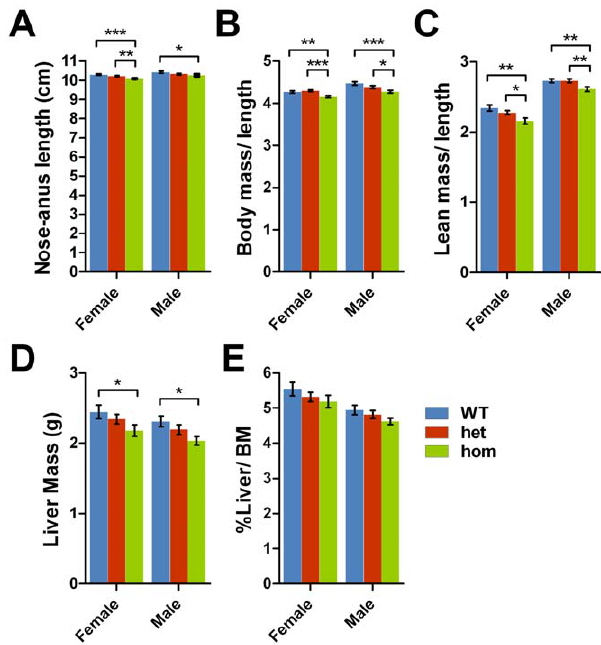
Figure 4. Negr1 -I87N mutants have altered body mass compo- sition. A–G . Body length (A), body mass (B) and lean mass (C) normalised to body length, liver mass (D) and percentage of liver mass to total body mass (E) of wild-type (female, n=23; male, n=16), heterozygous (female, n=37; male, n=36) and homozygous (female, n=17; male, n=19) Negr1 -I87N mice measured at 22 weeks in females and males. All data are presented as mean 6 SEM. Student’s t -test was carried out between groups, *, P , 0.05; **, P , 0.01; ***, P , 0.001.